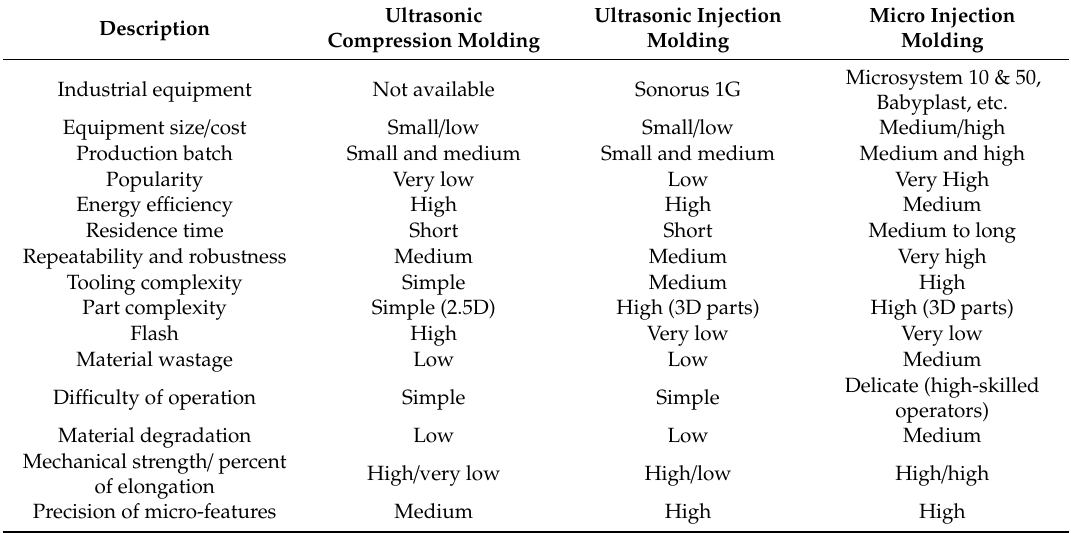
Table 3. Summary of the main characteristics of ultrasonic molding technologies and its comparison with micro-injection